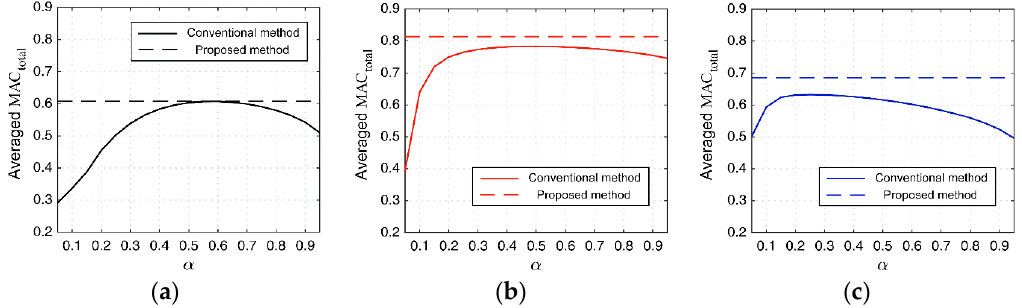
Figure 4. Averaged MAC total using short-time Fourier transform (STFT) with a 25-ms Hamming window, 10-ms hop length, and 512-point FFT for 1680 speech samples of conventional and proposed methods in ( a ) 0.37 s, ( b ) 0.69 s, and ( c ) 0.79 s of RT 60